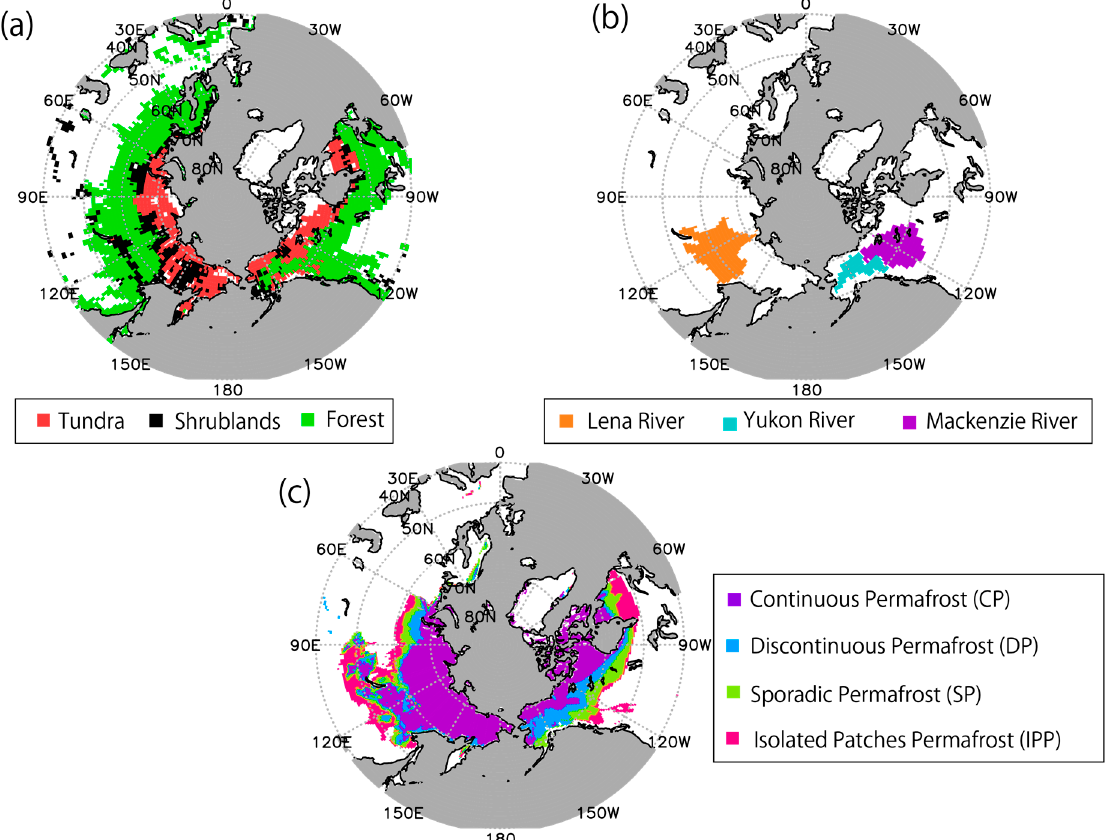
Figure 1. Maps of the study sites. ( a ) Vegetation map (red color denotes ACTR), ( b ) the largest pan-Arctic river basins, and ( c ) the permafrost distribution.